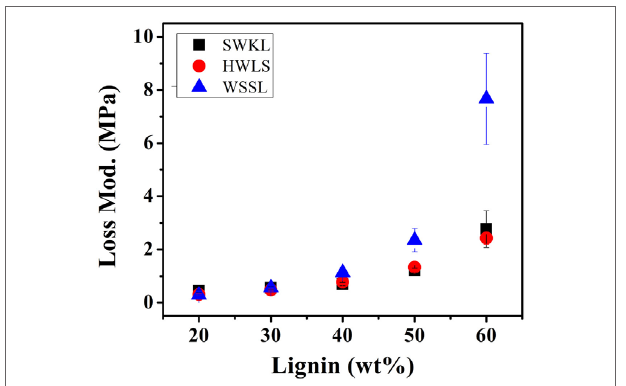
FigUre 7 | Loss modulus values of the lignin-based polyurethane samples obtained using dynamic mechanical analysis.